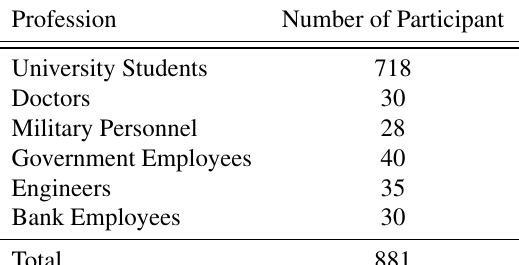
Figure 2. Student participants grouped by major area Most of them are students of public and few private